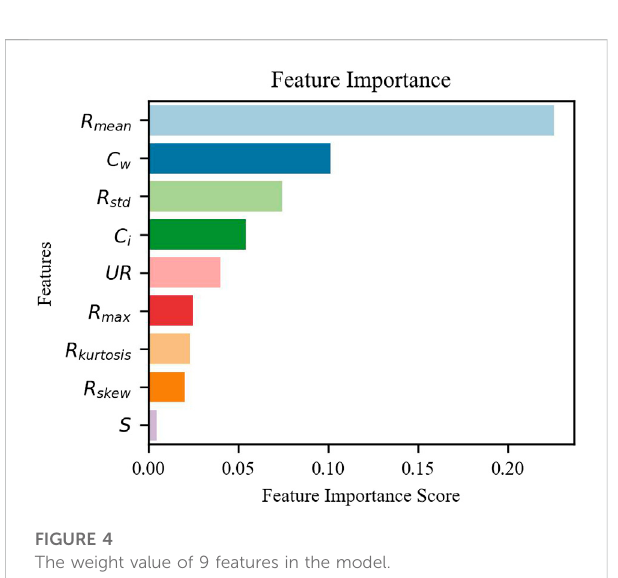
FIGURE 4 The weight value of 9 features in the